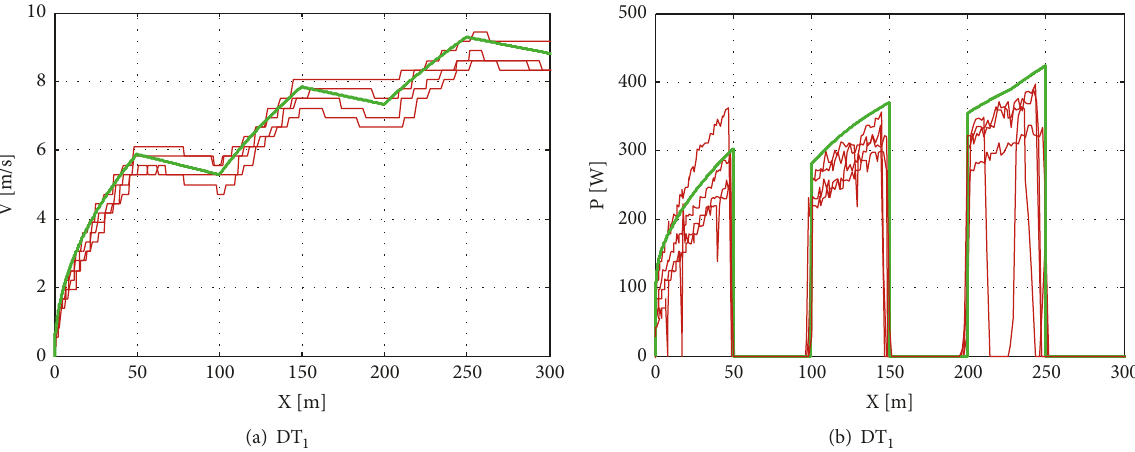
Figure 16: The velocity and the power determined with used DT1 drive